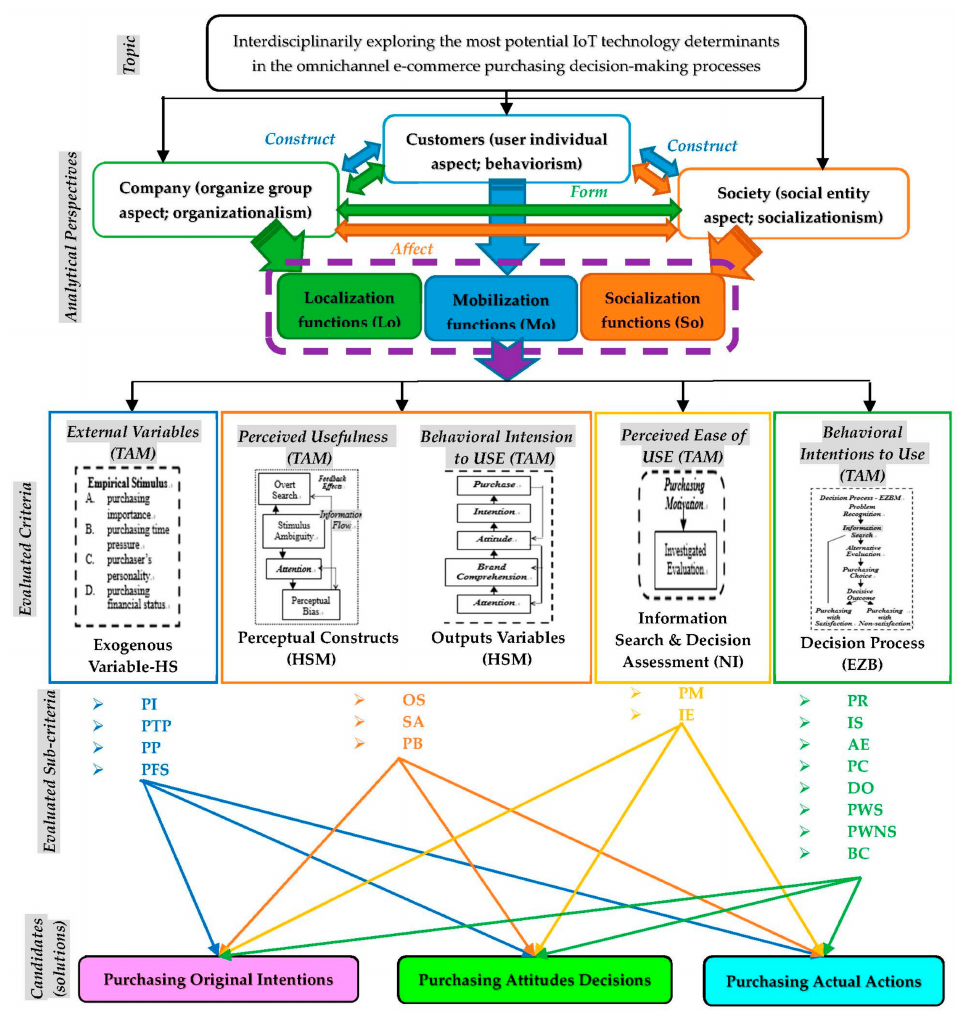
Figure 7. Main evaluated